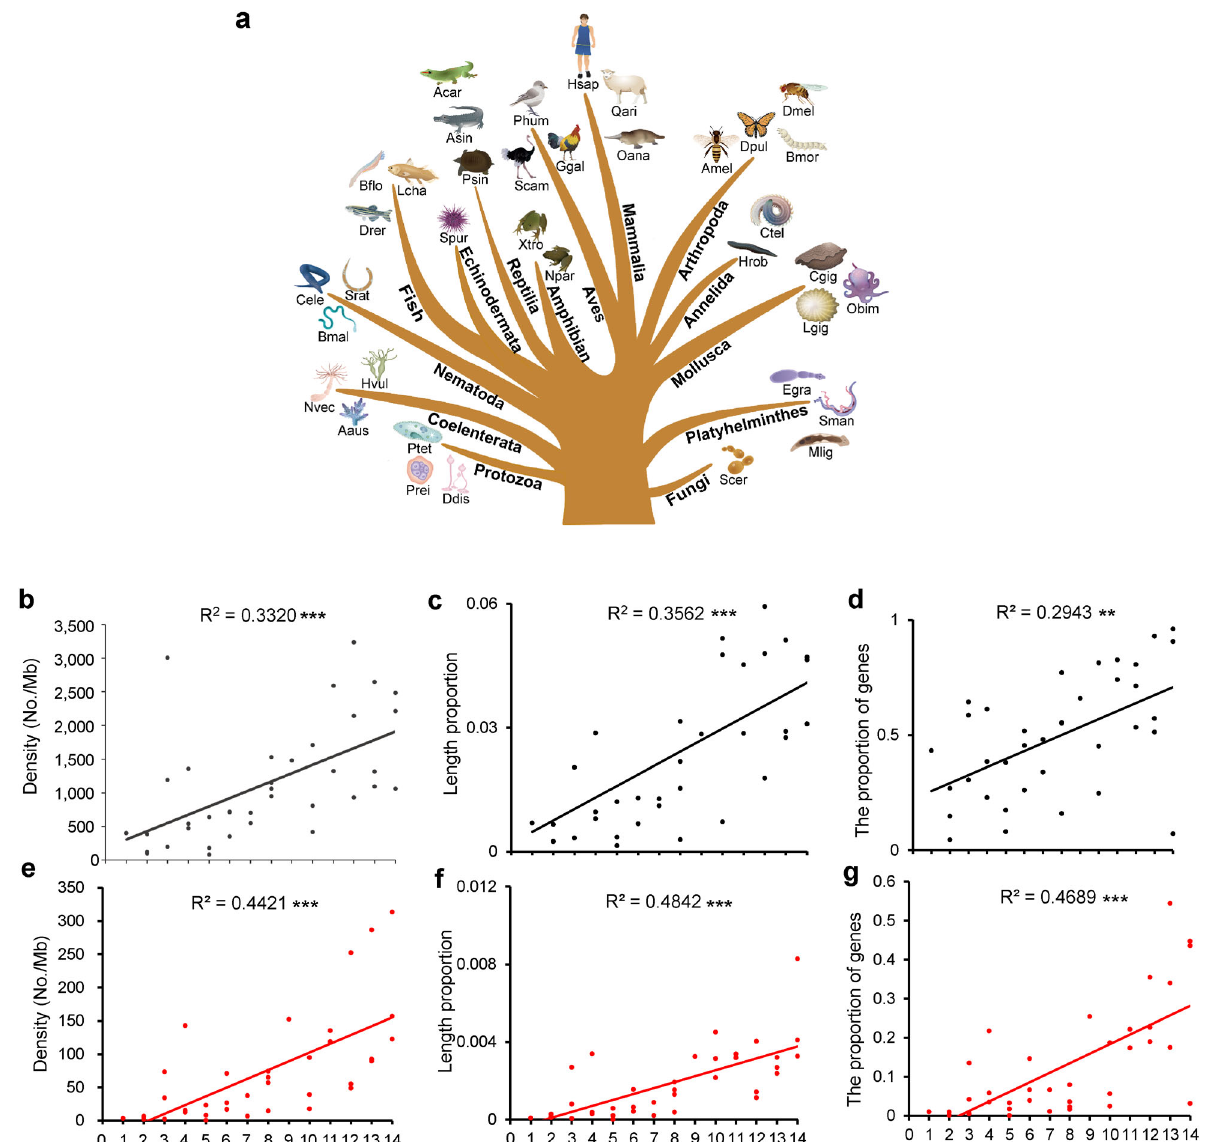
Fig. 1 Genomic landscape of G4 motifs in the selected species of the representative phylogenetic nodes in the tree of life. a Thirty-seven species in the phylogenetic tree, indicating the 14 representative evolutionary nodes from primitive eukaryotes to Animalia. b – g Genomic landscape of G4 motifs in the 37 species. The G4 density ( b , e ) and length ratio ( c , f ) in the genomes, and the ratios of the genes bearing G4 motifs in the upstream 2 kb region ( d , g ). b – d The data are presented based on all types of G4s [(G/C) 2 L 1 – 4 , (G/C) 3 L 1 – 7 , (G/C) 3 L 1 – 12, ), (G/C)4L 1 – 12 , and (G/C) 5 L 1 – 12, ]. d – f The data are presented based on the stable G4 structure (G/C) 3 L 1 – 7 . R 2 : goodness of fi t of the trend lines. * p < 0.05; ** p < 0.01; and *** p < 0.001 by F test. n = 37 biologically independent samples. Scer Saccharomyces cerevisiae , Prei Plasmodium reichenowi , Ptet Paramecium tetraurelia , Ddis Dictyostelium discoideum , Sman Schistosoma mansoni , Mlig Macrostomum lignano , Egra Echinococcus granulosus , Nvec Nematostella vectensis , Adig Acropora digitifera , Hvul Hydra vulgaris ,